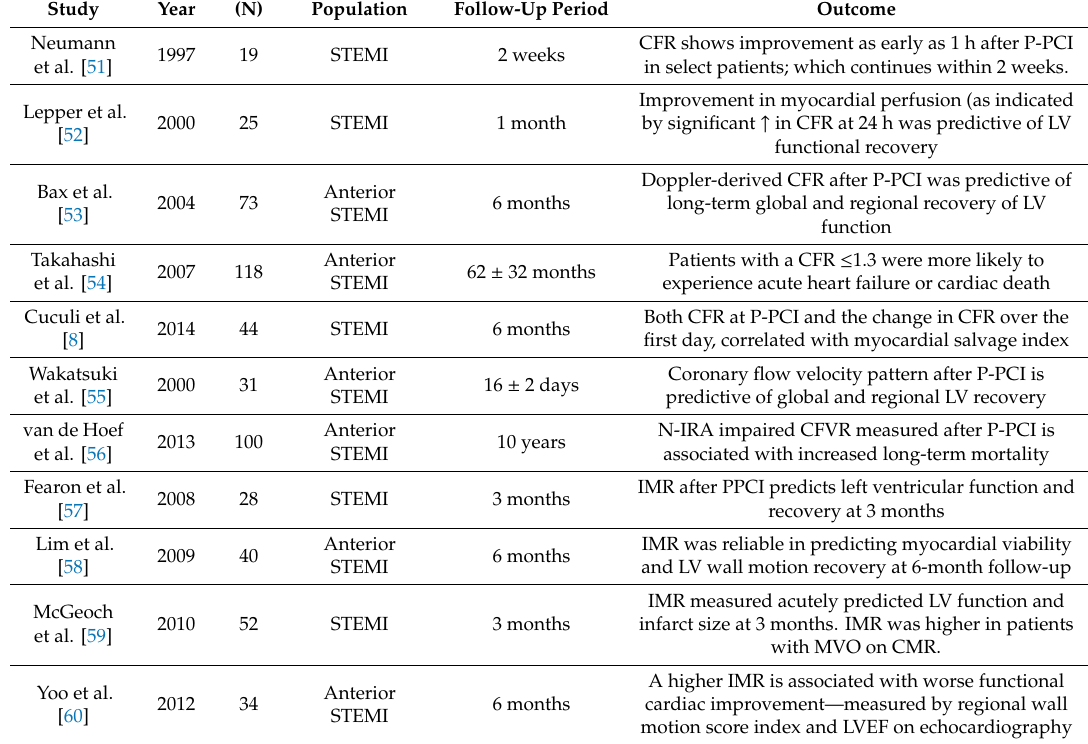
Improvement in myocardial perfusion (as indicated by significant ↑ in CFR at 24 h was predictive of LV functional